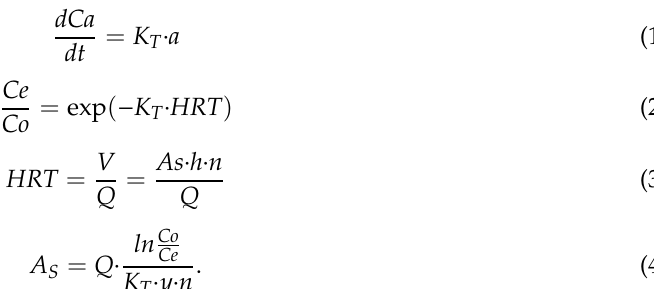
Table 1 defines the variables and parameters used in the sizing of subsurface flow